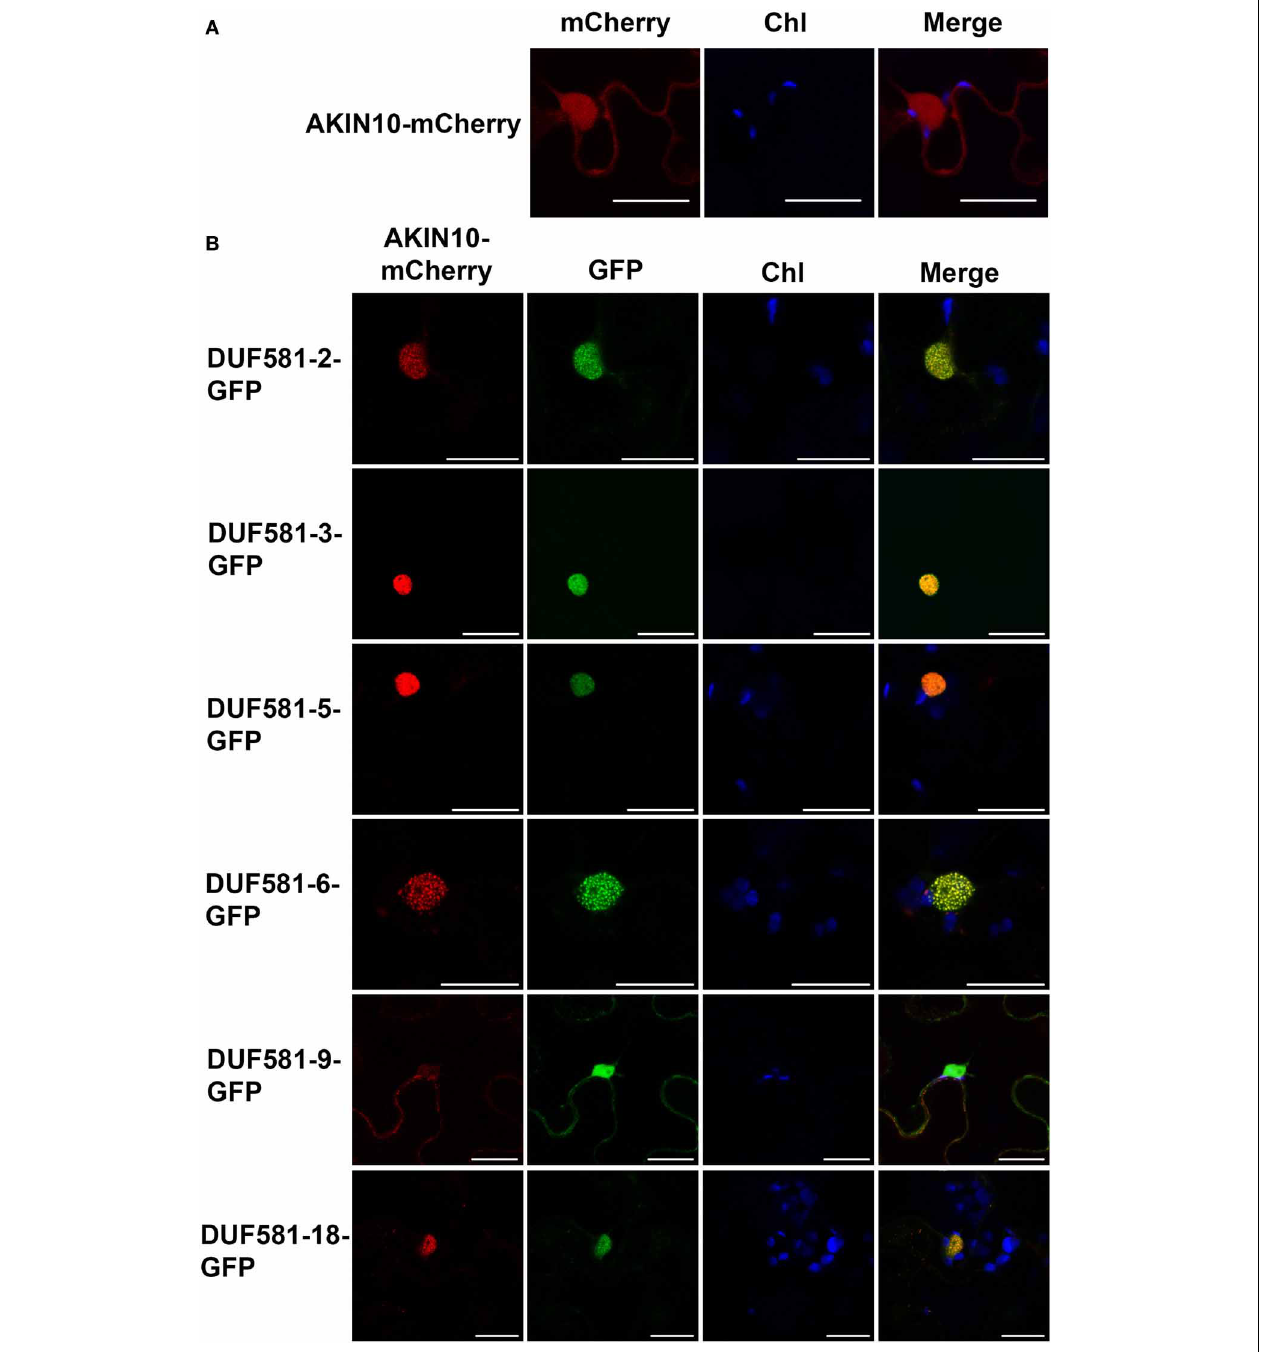
FIGURE 6 | AKIN10-mCherry and DUF581-GFP fusions co-localize in the nucleus. Subcellular localization of DUF581-GFP and AKIN10-mCherry fusions in N. benthamiana leaves transiently co-transformed by Agro-infiltration. The green fluorescence (GFP), red fluorescence (mCherry) and chlorophyll autofluorescence (Chl) were monitored separately to prevent